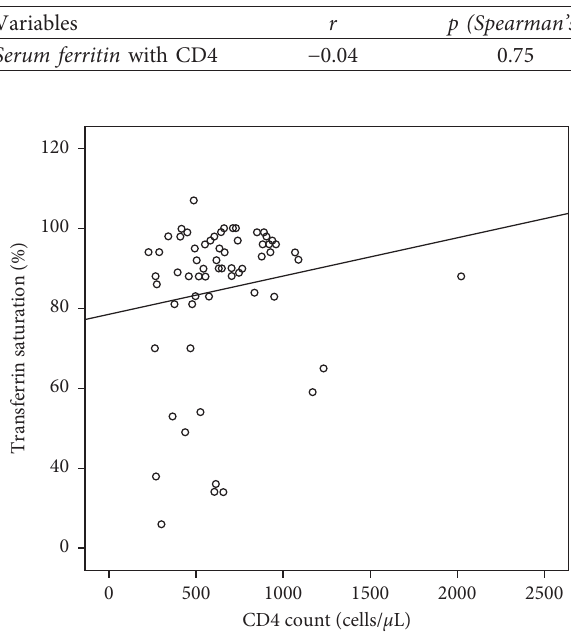
Figure 2: Scatter diagram of the correlation between transferrin saturation with CD4.